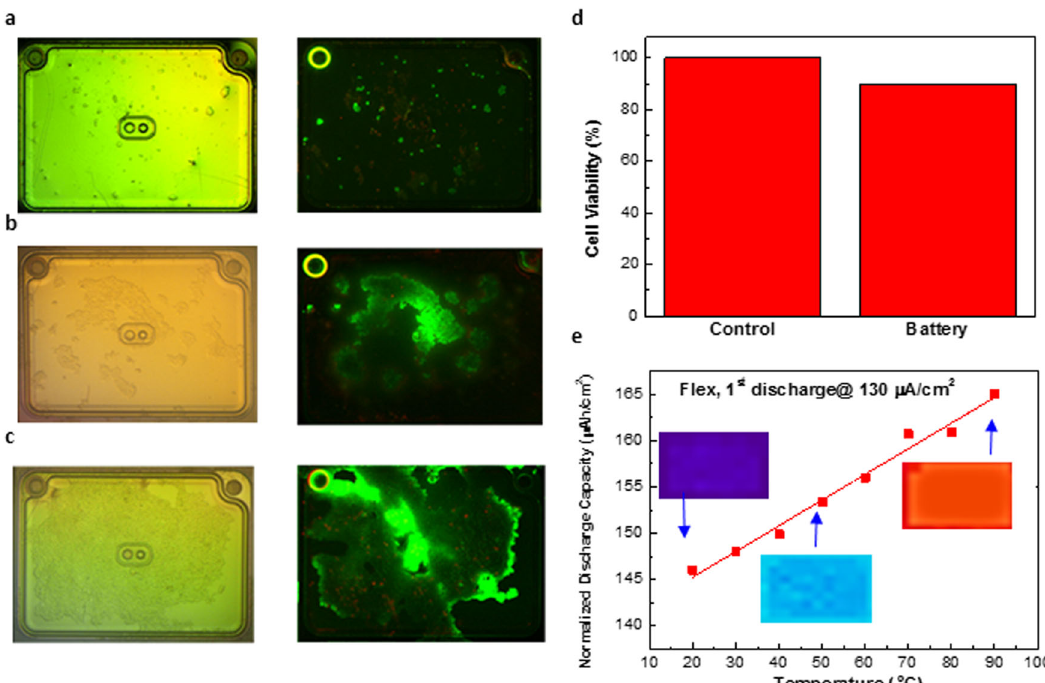
Fig. 4 Biocompatibility and thermal environmental testing for fl exible battery. Progressive HEK 293 cellular growth on the top surface of the non-cytotoxic battery identi fi ed by conventional optical and fl uorescent microscope images recorded at different times: a day 1, b day 3, and c day 5. (Left panels shows optical microscope images; right panels shows fl uorescence microscope images). Large green stains corresponds to the growing number of living cells compared to the trivial red stains corresponding to dead cells. d CCK8 cell viability assay compares cell culture density on the fl exible battery with a control group after 5 days of testing, which con fi rms the biocompatibility of the fl exible lithium- ion battery. e Temperature effect on the operation of the fl exible biocompatible battery compares the normalized discharge capacity at the fi rst discharge cycle recorded for multiple fl exible batteries heated at a designated temperature. The battery capacity increases with higher temperature as the battery ’ s internal resistance decreases. Thermal images of the battery are obtained during different